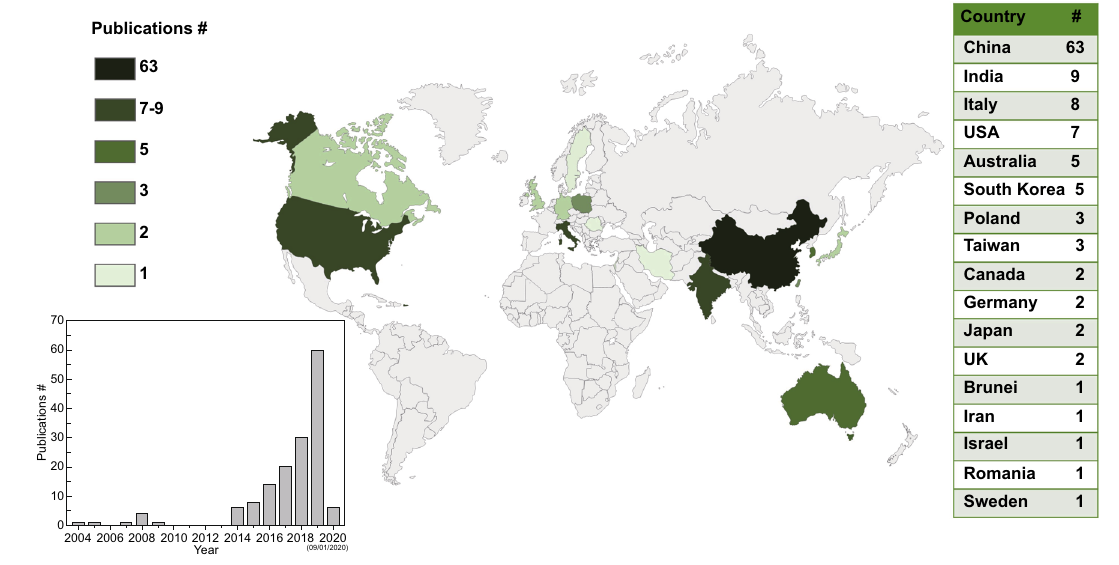
Fig. 15 Worldwide distribution of gold nanozyme publications, top‑producing countries in the field and annual progression in the field by num‑ ber of